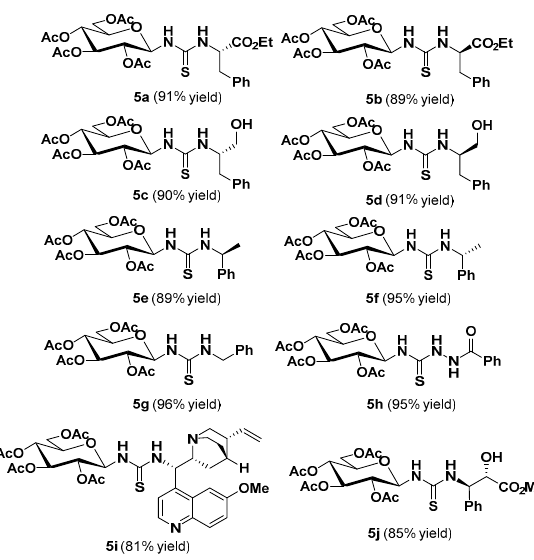
Figure 4. The structures of D -glucosyl thioureas 5a – j . Table 1. The larvicidal activities against Mythimna separata Walker of 5a – j .